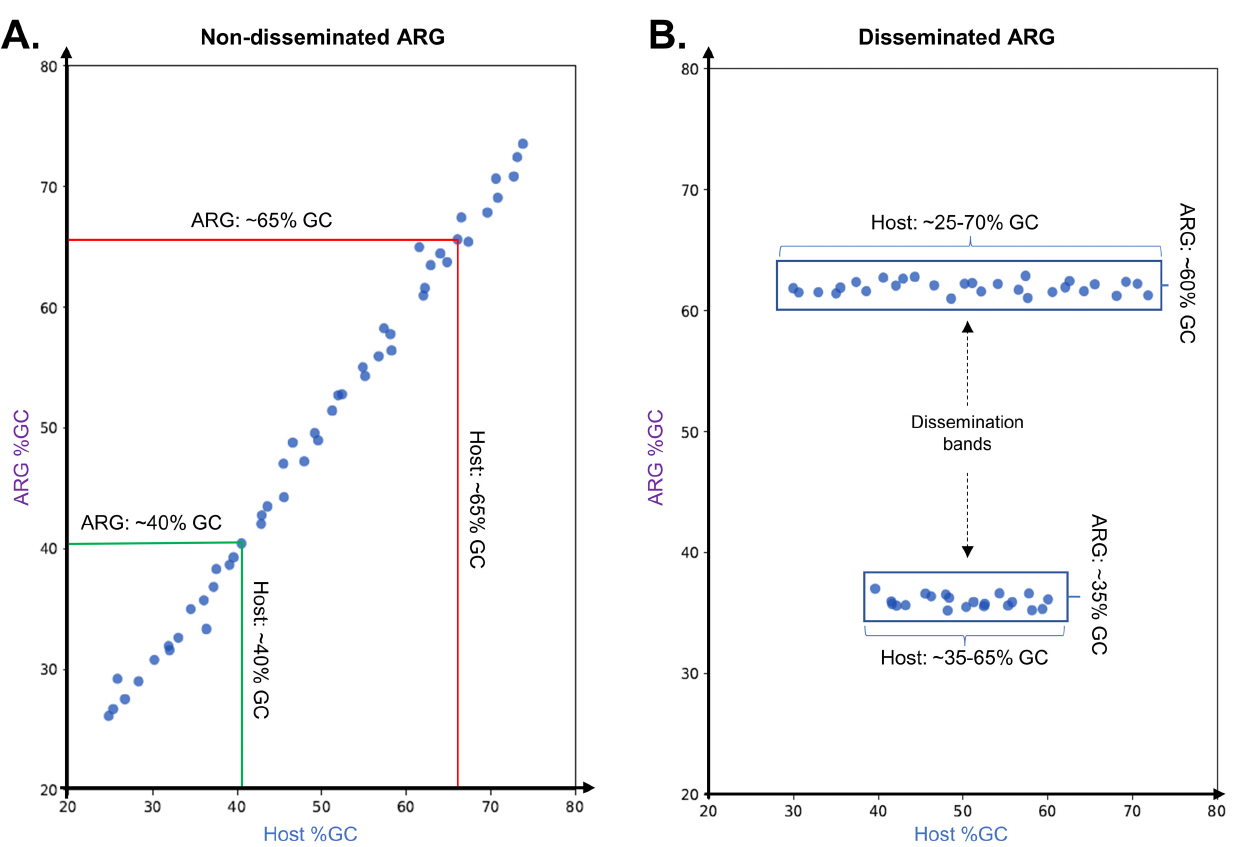
Figure 1. Graphical representation of hypothetical scenarios for the correlation between the %GC content of plasmid-borne ARG and that of their host genome. ( A ) The ARG %GC content is expected to align with the %GC content of the host chromosome when a resistance gene has been mobilized in multiple lineages but has been transferred only among closely related species. ( B ) The ARG %GC content is essentially independent of the host %GC content when a resistance gene has been rapidly disseminated from one or more mobilized instances to a heterogenous group of hosts, generating visible “dissemination